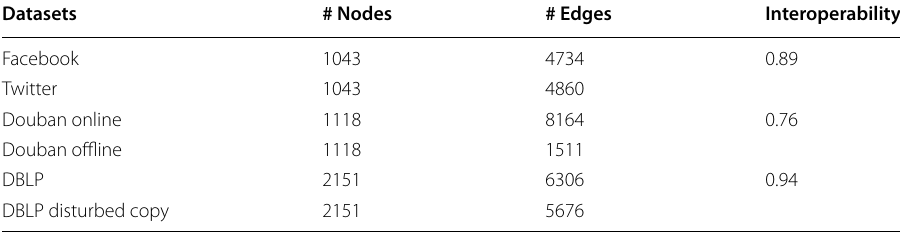
Table 1 Statistics for datasets used in experiments